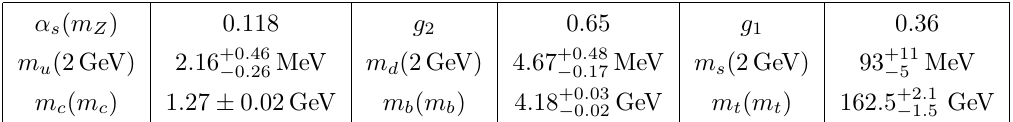
Table 19 . Standard Model parameters used in the solution of the